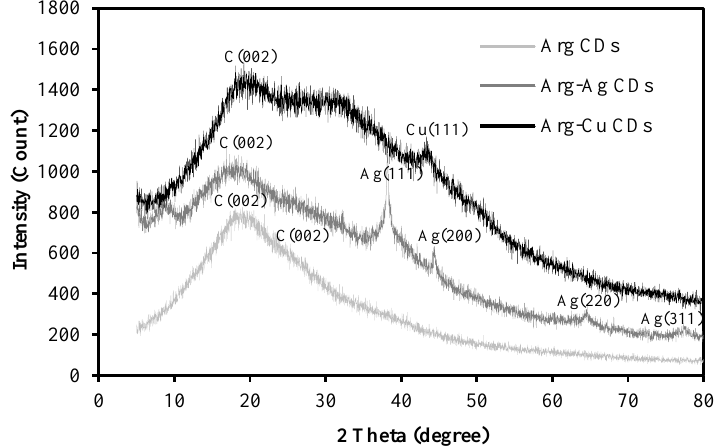
Figure 4. XRD patterns of Arg CDs, Arg-Ag CDs, and Arg-Cu CDs.